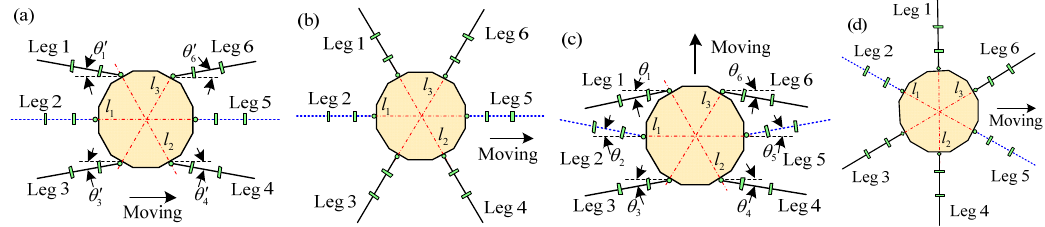
Figure 2. Four kinds of typical walking ways of heavy ‐ duty six ‐ legged robot under quadrangular gait: ( a ) crab type; ( b ) crab–ant mixed type I; ( c ) ant type; and ( d ) crab–ant mixed type II.